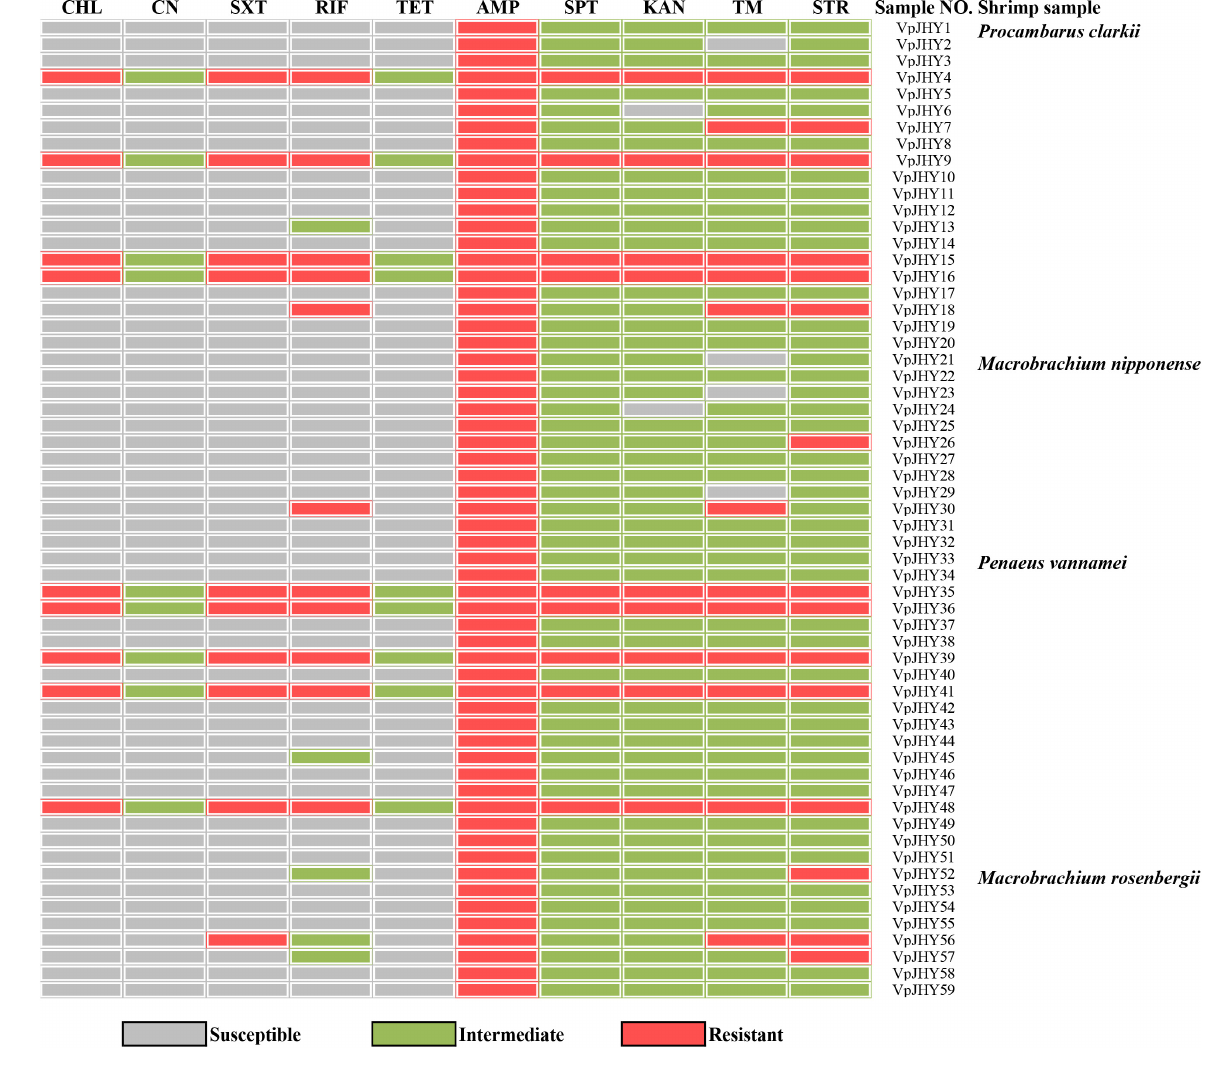
FIGURE 2 | Drug resistance of V. parahaemolyticus isolates. CHL, chloramphenicol; CN, gentamicin; SXT, sulfamethoxazole-trimethoprim; RIF, rifampicin; TET, tetracycline; AMP, ampicillin; SPT, spectinomycin; KAN, kanamycin; TM, trimethoprim, and STR,